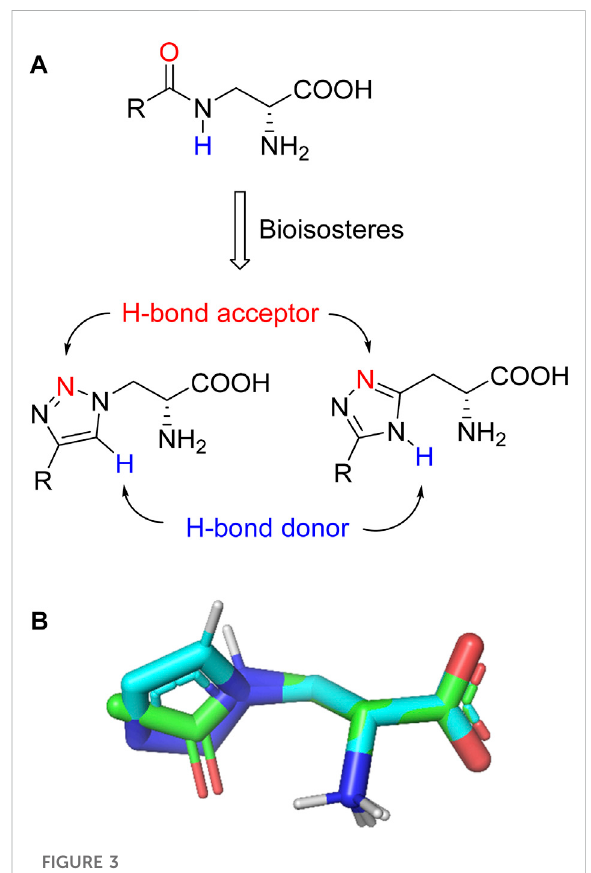
FIGURE 3 (A) Design strategy for novel triazole analogues as NMDA receptor Gly site agonists. (B) Overlay of lowest energy conformations for β -amide- D -alanine (green) and β